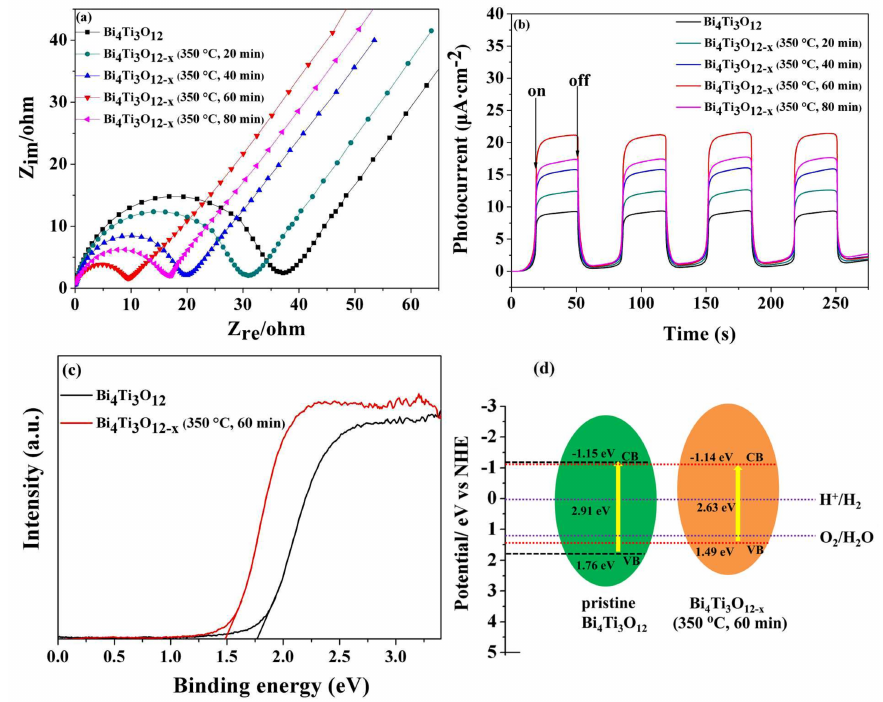
Figure 9. ( a ) The electrochemical impedance spectroscopy (EIS) Nyquist plots of the pristine Bi 4 Ti 3 O 12 and various Bi 4 Ti 3 O 12 − x samples after the buildup on the ITO electrodes with visible-light ( λ > 400 nm) irradiation; ( b ) Photocurrents of the pristine Bi 4 Ti 3 O 12 and various Bi 4 Ti 3 O 12 − x samples after the buildup on the ITO electrodes under visible-light irradiation ( λ > 400 nm); ( c ) valence band XPS spectra of the pristine Bi 4 Ti 3 O 12 and Bi 4 Ti 3 O 12 − x (350 ◦ C, 60 min); ( d ) the probable band energy diagram of the pristine Bi 4 Ti 3 O 12 and Bi 4 Ti 3 O 12 − x (350 ◦ C, 60